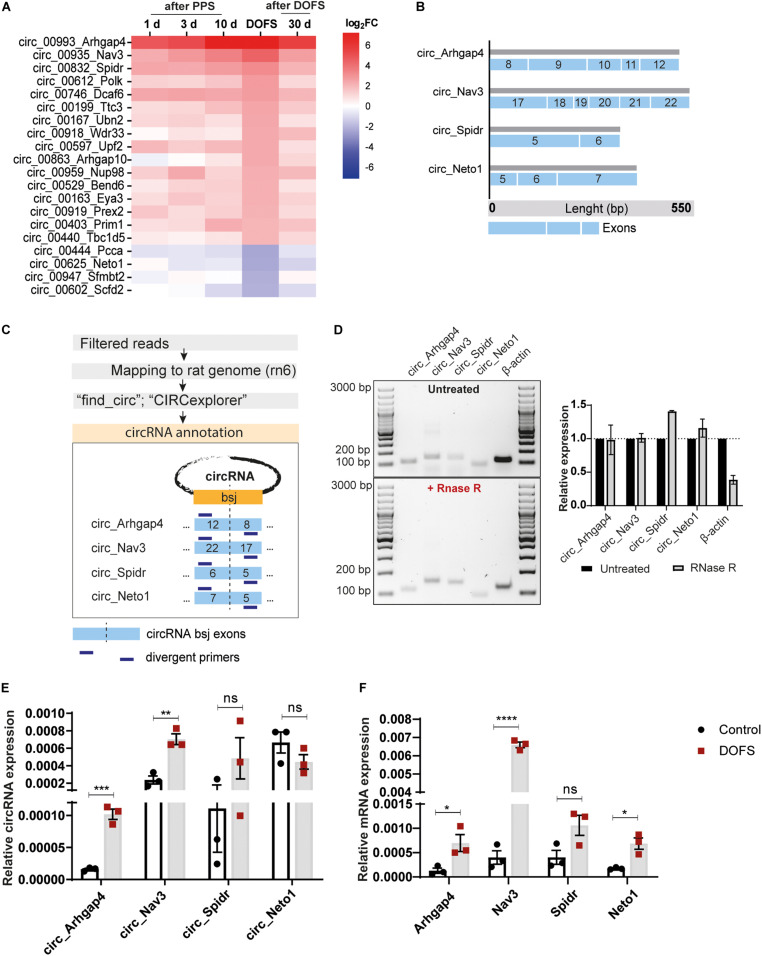
Validation of the expression of selected circRNAs and their linear counterparts at the DOFS. (A) Heatmap showing relative expression changes of the most deregulated rat-specific circRNAs. (B) Characterization of selected circRNAs (circ_Arhgap4, circ_Nav3, circ_Spidr and circ_Neto1) showing exonic composition, length and exon number. Each blue box represents one exon and the different sizes of the different exonic lengths. (C) Schematic workflow of the pipeline used for the annotation of selected circRNAs and subsequent divergent primer design. Two complementary pipelines (“find_circ” and “CIRCexplorer”) were used for the annotation of circRNA sequences. The BSJ of each circRNA was defined as a 100 bp junction between the last and first circRNA exon (blue box). Divergent primers were designed against this region for each circRNA (bsj, back-splice junction). (D) Agarose gel electrophoresis of the PCR products from circRNA back-splice junction amplification with (upper panel) and without (lower panel) RNase R treatment. Original images were color inverted for improved visualization. Quantification of RNA expression is shown in the right panel. Values are expressed as the mean ± SD. RNase R-treated expression is normalized to the untreated condition (n = 2 independent experiments) (bp, base pairs). (E) RT-qPCR analysis of the expression pattern of circRNAs at DOFS (circ_Arhgap4, ***p = 0.0005; circ_Nav3, **p = 0.0038; circ_Spidr, ns; circ_Neto1, ns). The bar plots represent circRNA expression relative to β-actin and Gapdh. Values are expressed as the mean ± SEM, p < 0.001: ***, p < 0.01: **, p ≥ 0.05: ns (unpaired two-tailed Student’s t-test, n = 3 animals per group). (F) RT-qPCR analysis of the expression pattern of circRNAs’ linear counterparts at DOFS (Arhgap4, *p = 0.0354; Nav3, ****p < 0.0001; Spidr, ns; Neto1, *p = 0.0124). The bar plots represent mRNA expression relative to β-actin and Gapdh. Values are expressed as the mean ± SEM, p < 0.0001: ****, p < 0.05: *; p ≥ 0.05: ns (unpaired two-tailed Student’s t-test, n = 3 animals per group).